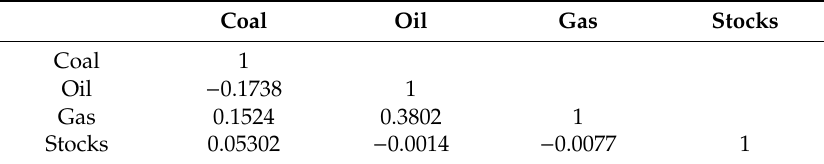
Table 13. Correlations for Germany.